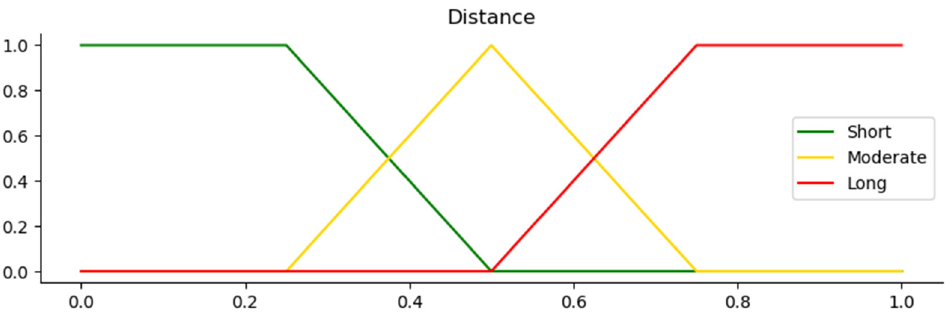
Figure 3. Membership function of Criterion 1 (Equation (1)) of traveled distance.